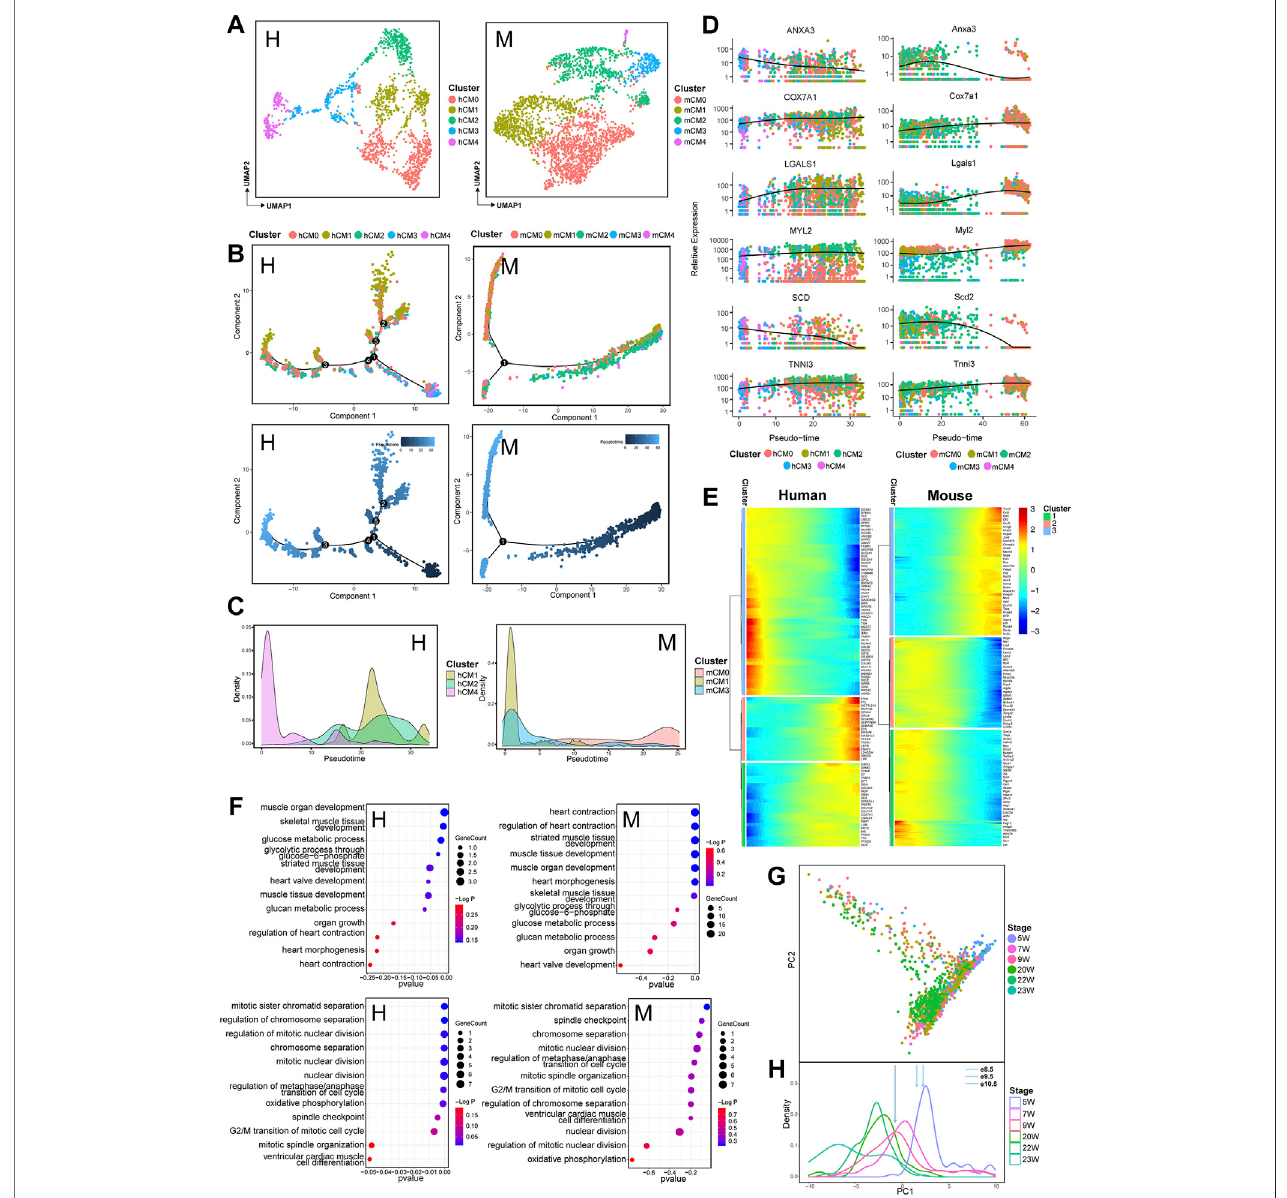
FIGURE 3 | Transcriptomic dynamics of cardiomyocytes during human and mouse heart development (human: H, left; mouse: M, right). (A) UMAP plots showing the subpopulations of human (H) and mouse (M) cardiomyocytes. (B) Pseudotemporal trajectory of CM subpopulations constructed by Monocle2. Upper: colored by CMsubpopulations;Lower: coloredbypseudotimevalues,withthevalueranging fromsmall tolarge representing thestarttotheendofthedevelopmentalprocess. (C) Density plot of the distribution of CM subpopulations along the trajectory. (D) Dot plots showing the expression of genes conserved along the trajectory in two species. (E) Heatmap showing the expression pattern of cardiomyocytes along the developmental trajectory. (F) GO enrichment analysis (BP) of the genes in cardiomyocytes with different expression patterns along the trajectory between two species. (G) PCA plot of cardiomyocyte expression at various time points in human hearts. (H) PCA-baseddensityplotdepictingtheproportionofhCMsatvarioustimepoints,showingaconsiderableoverlapintemporaldevelopmentfrom5 Wto24 W. The arrows represent the mean expression of different developmental stages of mouse CMs.